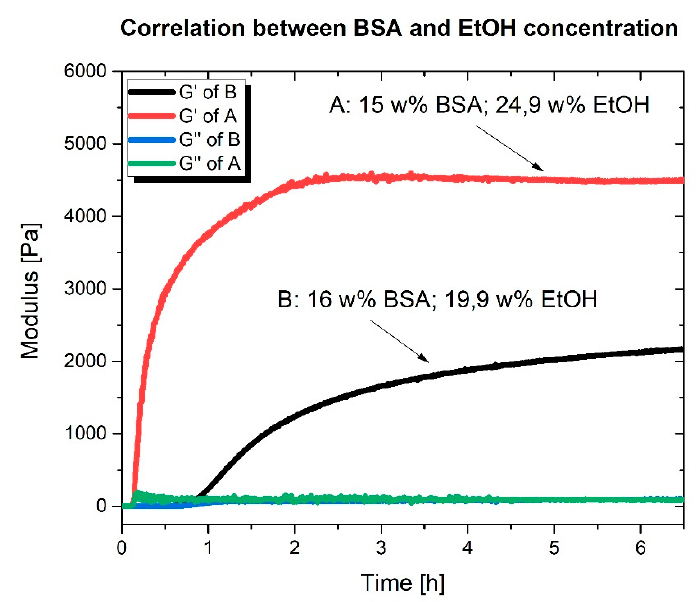
Figure A3. This figure illustrates that there is a correlation between ethanol and protein concentration. In A, although the BSA concentration is lower, due to the presence of more ethanol, a mechanically more robust gel is formed. In B, still a gel forms, but a higher concentration of BSA does not lead to a stronger gel structure, since the amount of ethanol is lower compared to A.